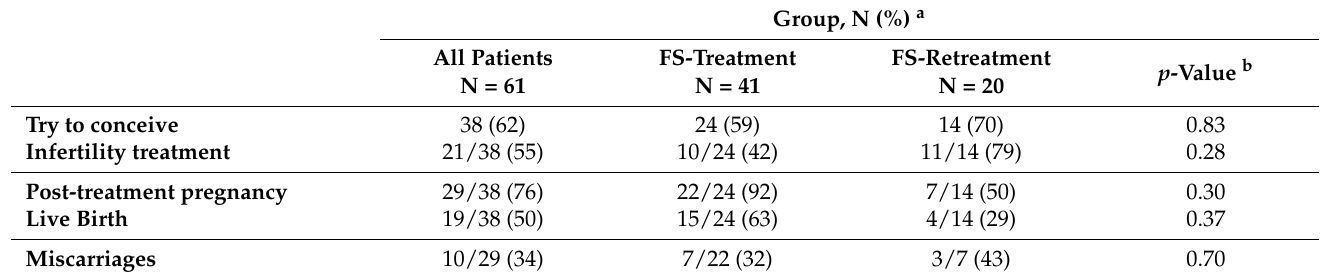
Table 3. Obstetrical outcomes of primary fertility-sparing treatment and